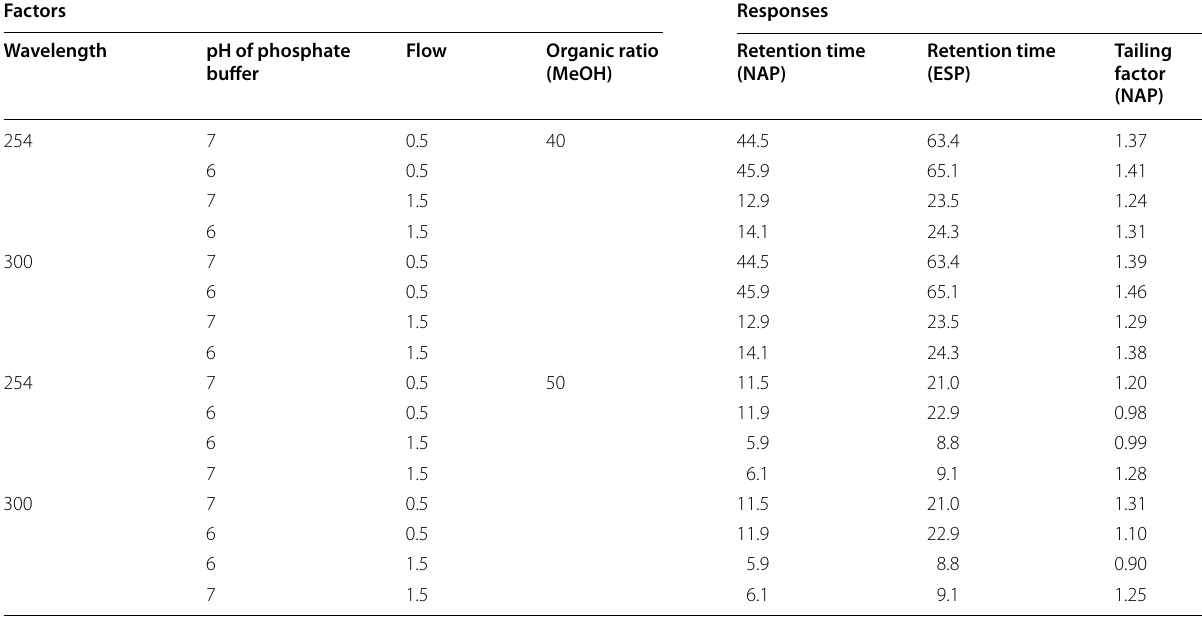
Table 1 DoE experiment for method optimization Factors